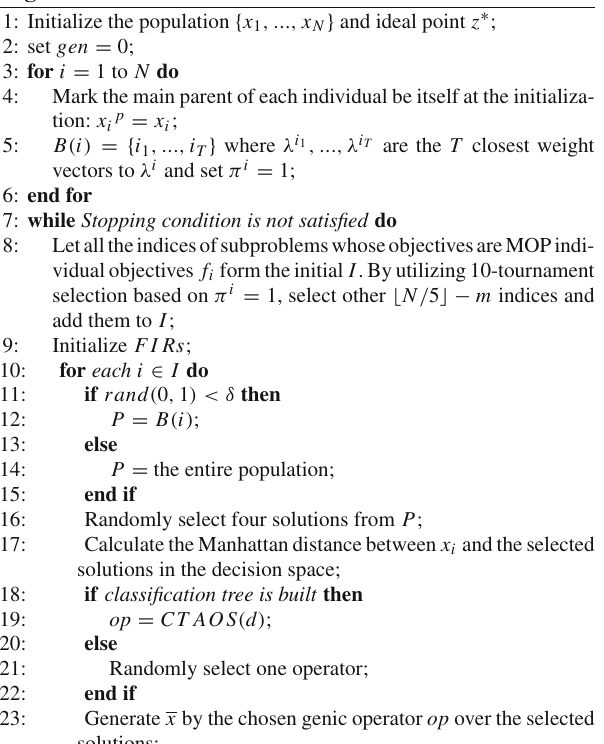
Algorithm 2 Procedure of Operator Selection Algorithm 3 Pseudo of